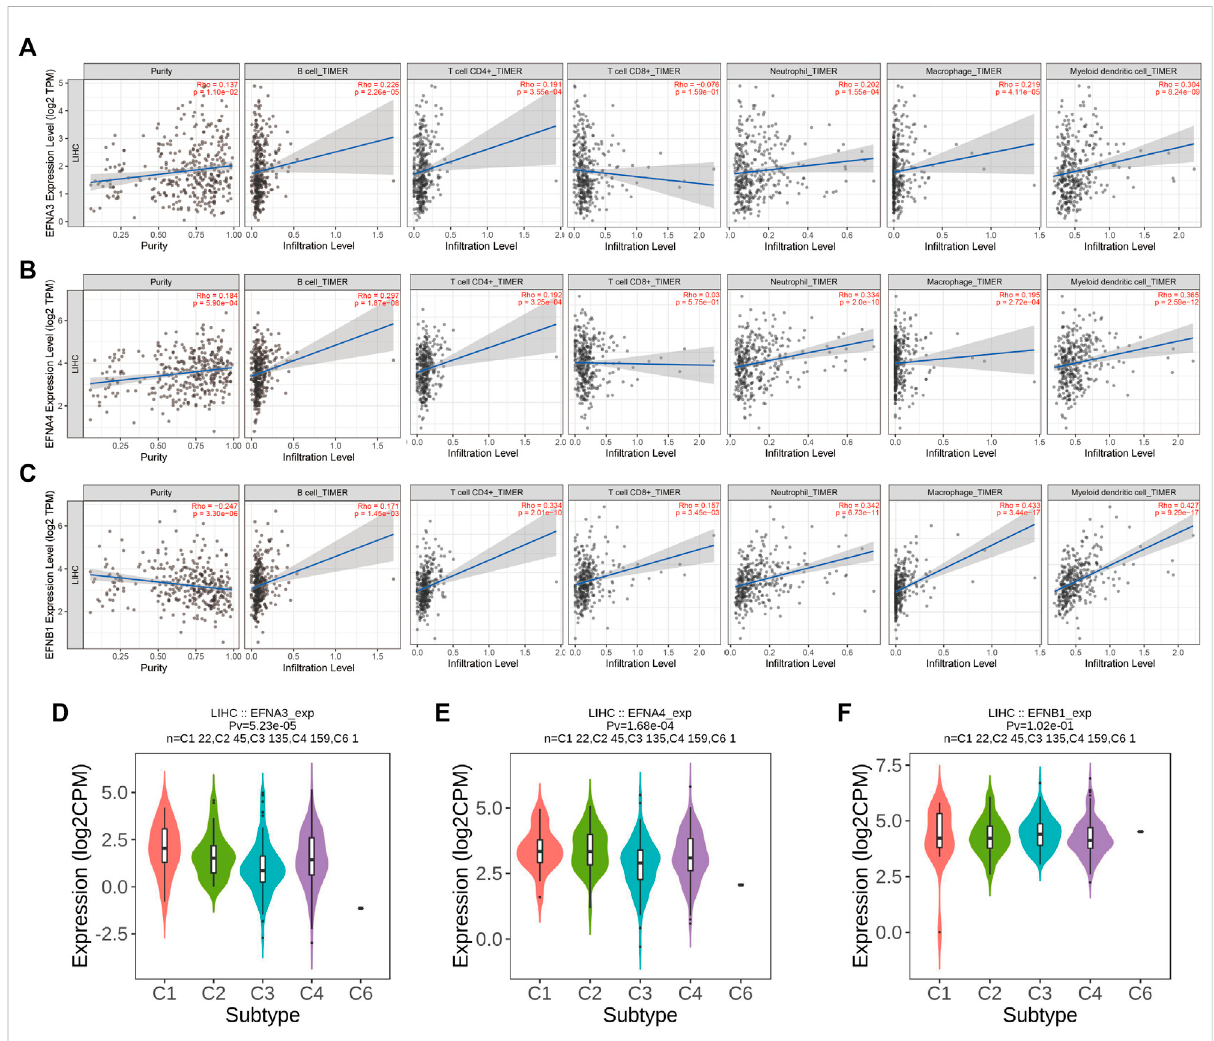
FIGURE 7 Correlation of signi fi cant prognostic ephrin genes with tumor-in fi ltrating immune cells and immune subtypes in HCC using TIMER algorithms. (A) EFNA3; (B) EFNA4;and (C) EFNB1.Tumorpurityisshowninthepanelsontheleft. (D – F) Thecorrelationbetweenprognosticephringenes(EFNA3, EFNA4, and EFNB1) expression and immune subtypes in HCC using TISIDB. Rho, Spearman ’ s rank coef fi cient; Pv, p value; C1, wound healing; C2, IFN-gamma dominant; C3, in fl ammatory; C4, lymphocyte depleted; C5, immunologically quiet; C6, TGF-b